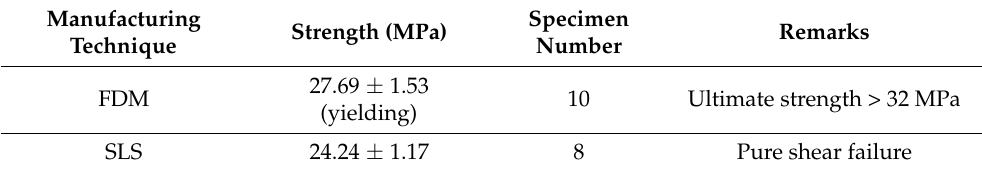
Table 1. Interlayer shear strengths of the same PA 12 polymer made with SLS and FDM.